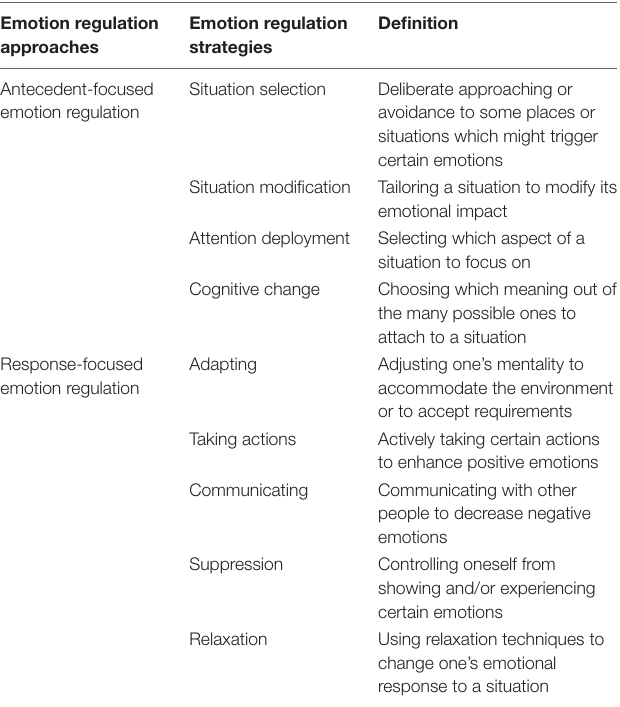
TABLE 1 | Emotion regulation approaches and strategies adapted from Gross (1998), Gross (2015), Gu and Gu (2019), and Han and Xu (2021). Emotion regulation Emotion regulation approaches